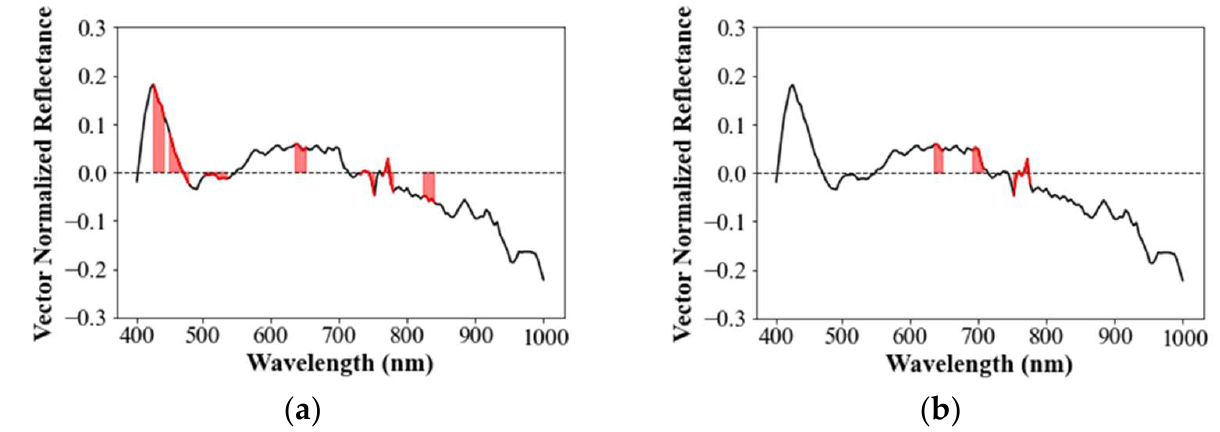
Figure 8. Characteristic spectral library of phosphorus trichloride (red color). ( a ) Primary character- istic spectral library of Phosphorus trichloride; ( b ) final characteristic spectral library of phosphorus trichloride.